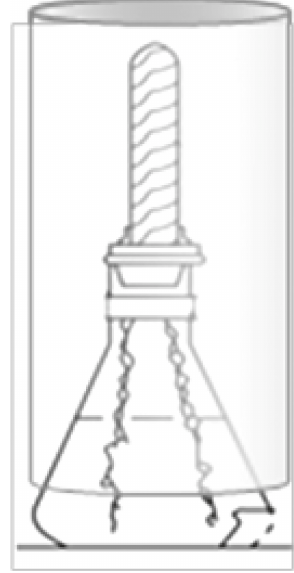
Figure 2: Proposed scheme for sample’s collection in the covered candle